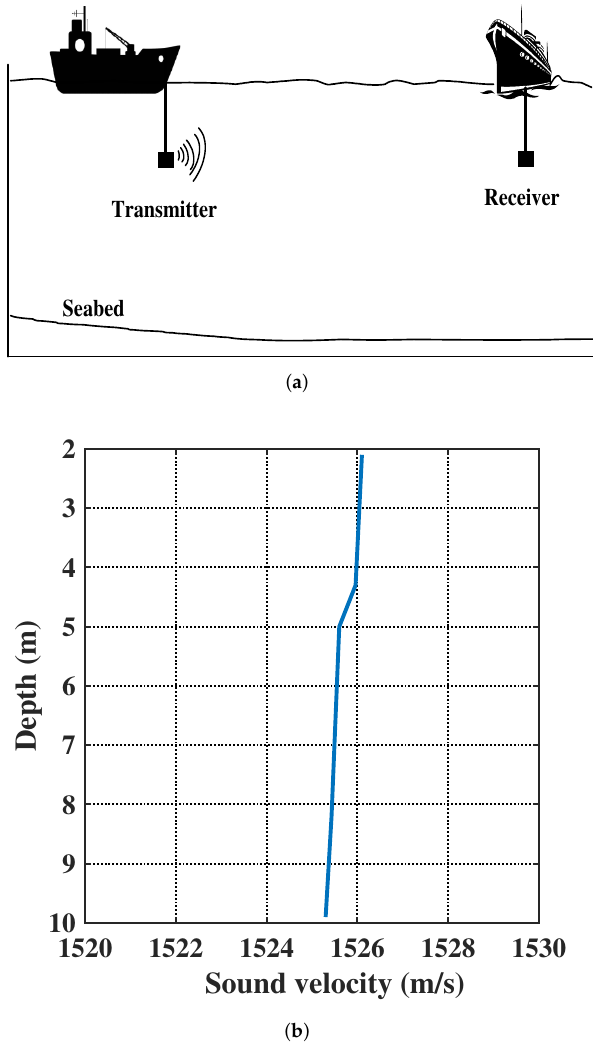
Figure 10. Setup of the field experiment and the corresponding sound velocity profile. ( a ) Setup of the field experiment. ( b ) Sound velocity profile.